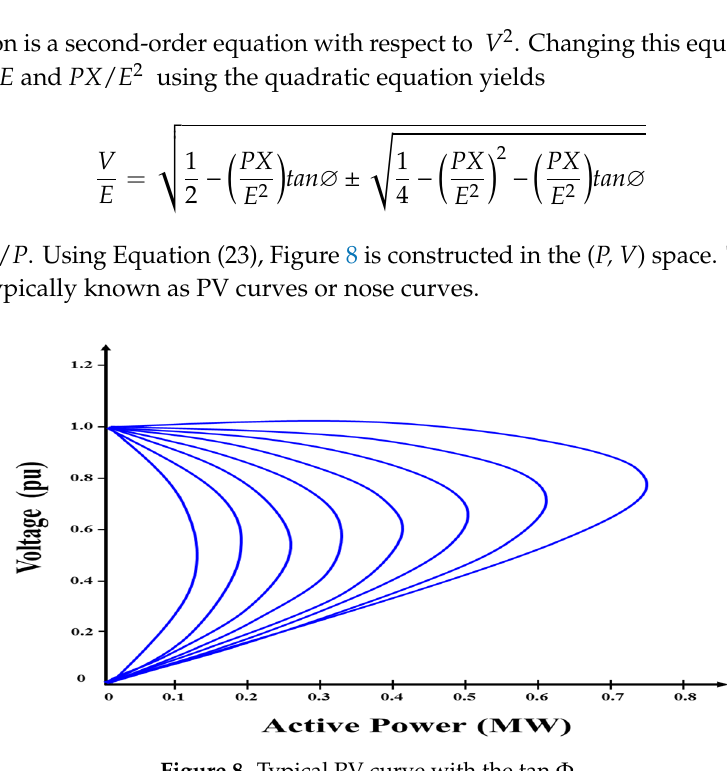
Figure 8. Typical PV curve with the tan Φ .